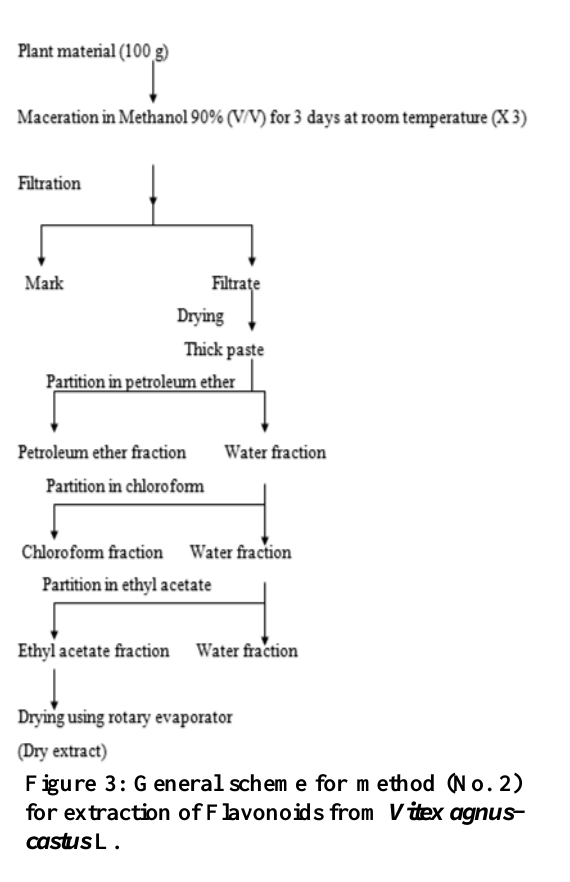
Figure 3: General scheme for method (No. 2) for extraction of Flavonoids from Vitex agnus- castus